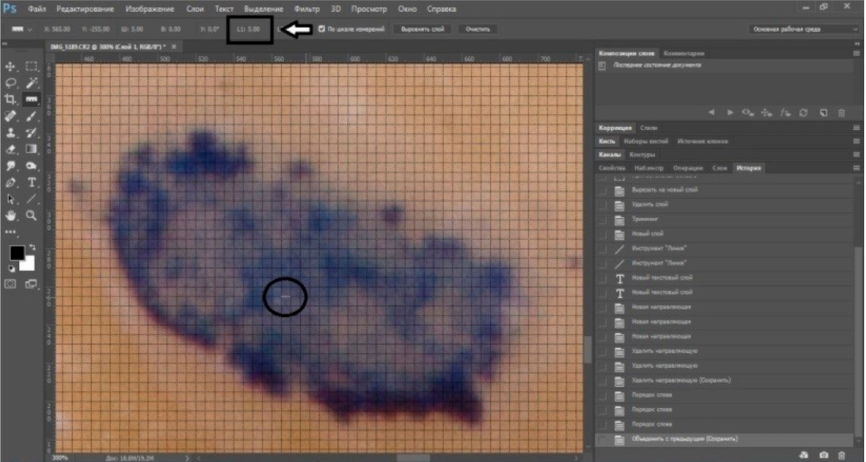
Figure 1. Occlusal contact with a digital